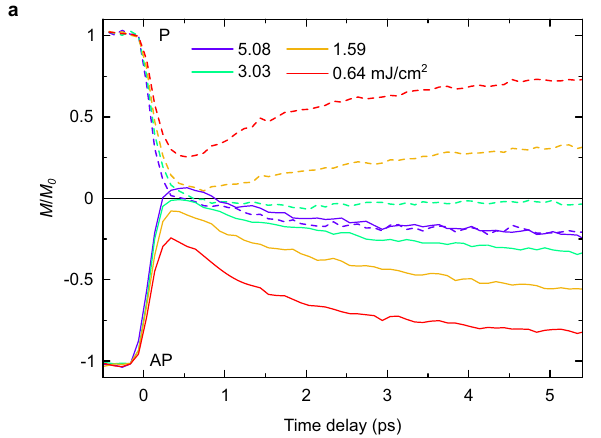
Fig. 3 | Experimental and simulated magnetization dynamics of the [Co/Pt] multilayer.a Experimentalnormalizedmagnetizationultrafastdynamicswhenthe sampleisinitiallypreparedinaP(dashedlines)orAP(solidlines)con fi gurationfor